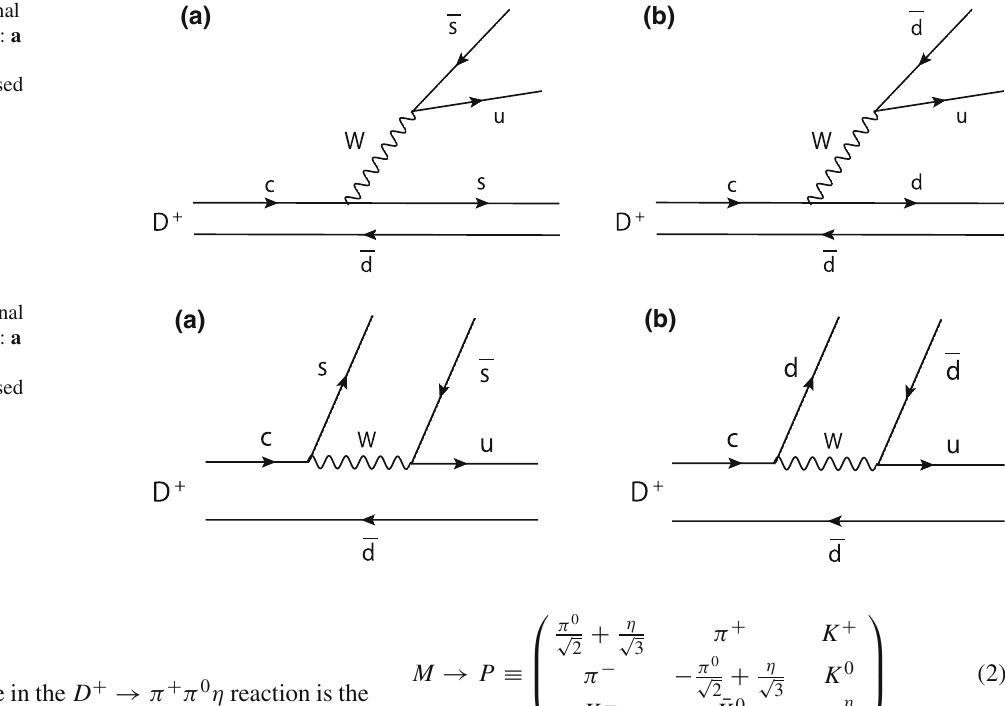
Fig. 1 Diagrams of external emission at the quark level: a Cabibbo suppressed Wu ¯ s vertex, b Cabibbo suppressed Wcd vertex